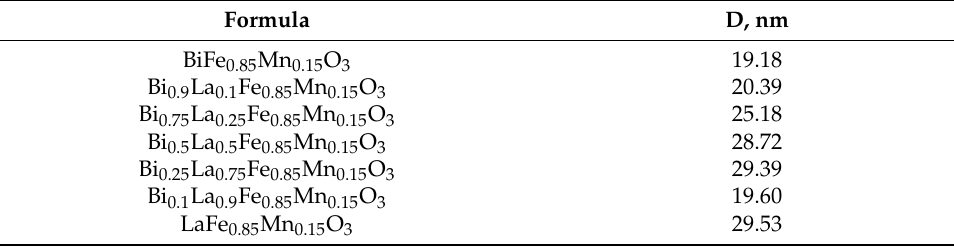
Table 1. Crystallite size for Bi 1-x La x Fe 0.85 Mn 0.15 O 3 solid